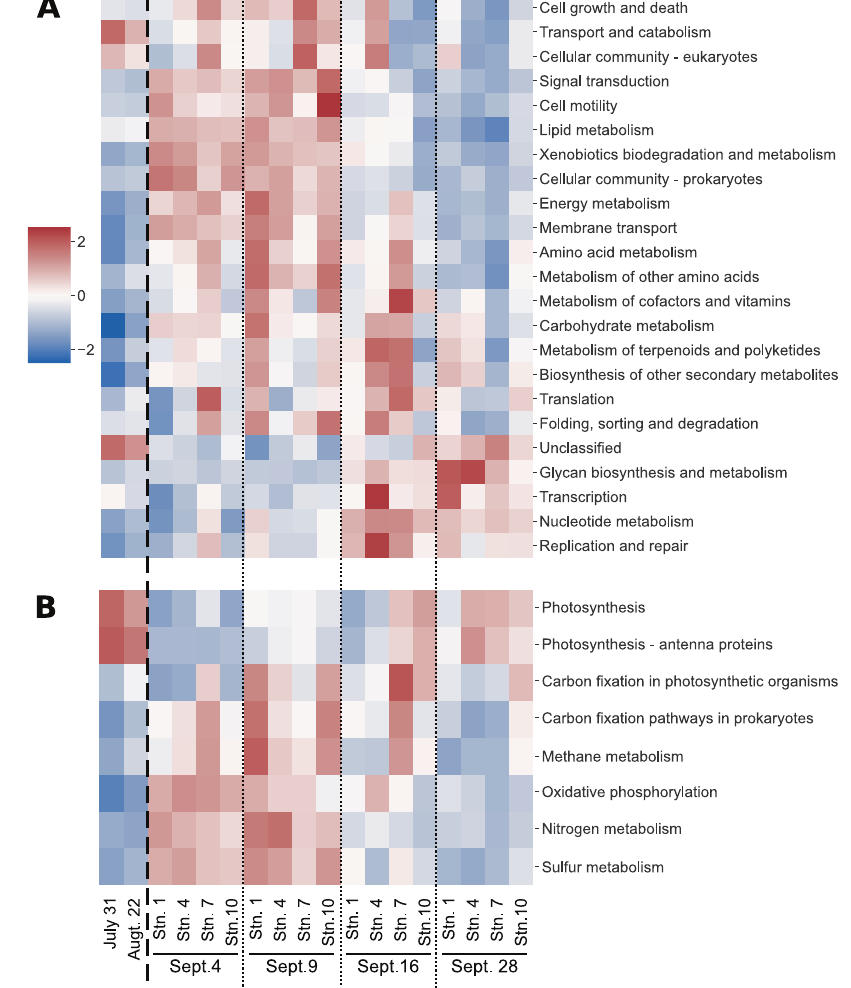
Fig. 6 Heat map showing the z -score for genes in the complete metagenomes that were in the KEGG category of energy metabolism. The z -score is calculated using the proportion of KEGG pathways ( A ) and KEGG modules ( B ) identi fi ed in each metagenome to the total number of Prodigal predicted genes, darker red (3.5) there are above average reads and darker blue ( − 3.5) there are below average reads. MAGs clustering on Sept. 4 and Sept. 9 (Fig. 7B). Of these outliers, bioenv() results indicating the temperature, salinity, and pH were two had rRNA genes, one with 100% identity to Cylindrospermopsis the most in fl uential factors and that the functions grouped signi fi cantly by sampling date (analysis of similarity R > 0.7 and